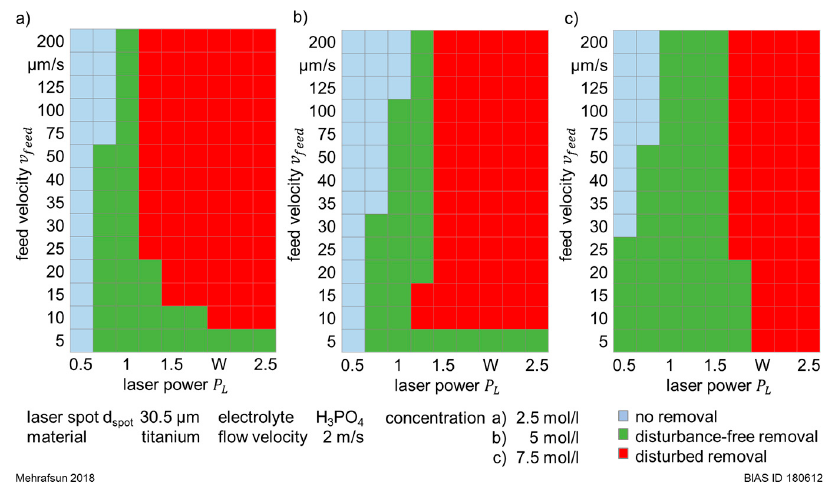
Figure 11. Experimentally determined LCM removal regimes in titanium machined in phosphoric acid solutions with concentrations of ( a ) 2.5 mol/L; ( b ) 5 mol/L; and ( c ) 7.5 mol/L.